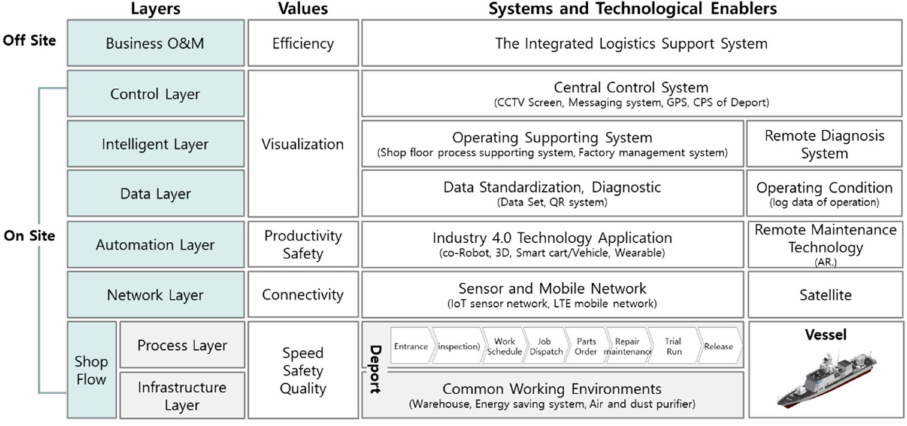
Figure 8. Technology architecture of a vessel smart maintenance